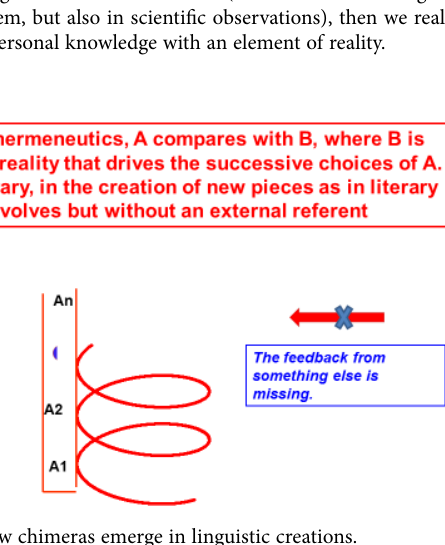
Figure 16. How chimeras emerge in linguistic